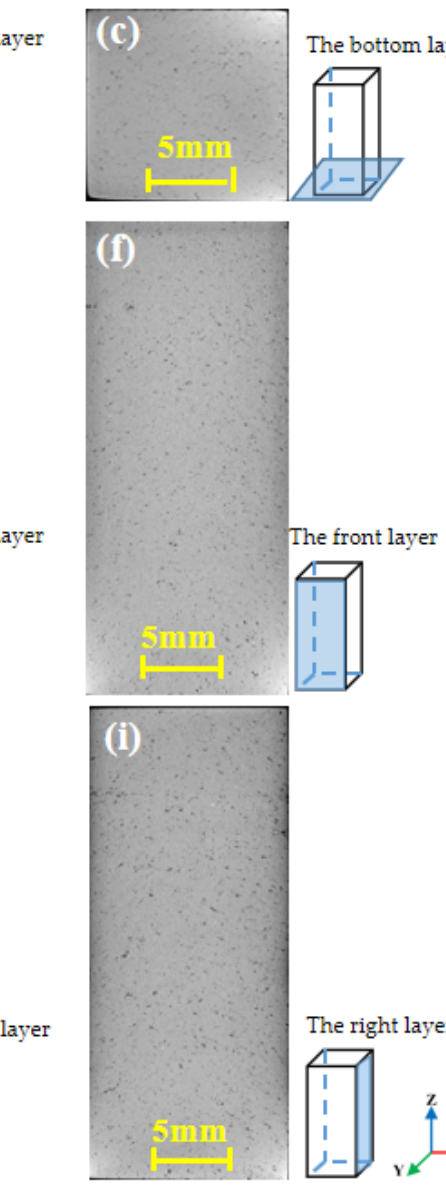
Figure 12. Density of sample 2 along Z-axis.